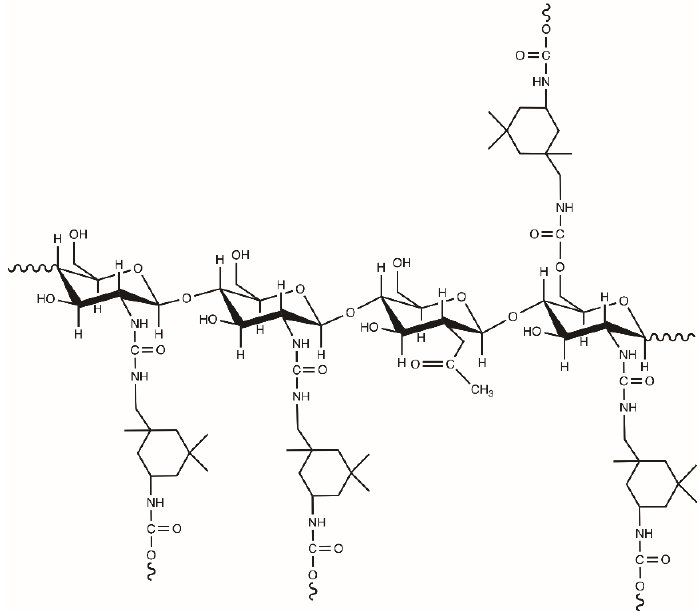
Figure 2. Proposal structure of waterborne polyurethane extended by chitosan (prepared in [20]).